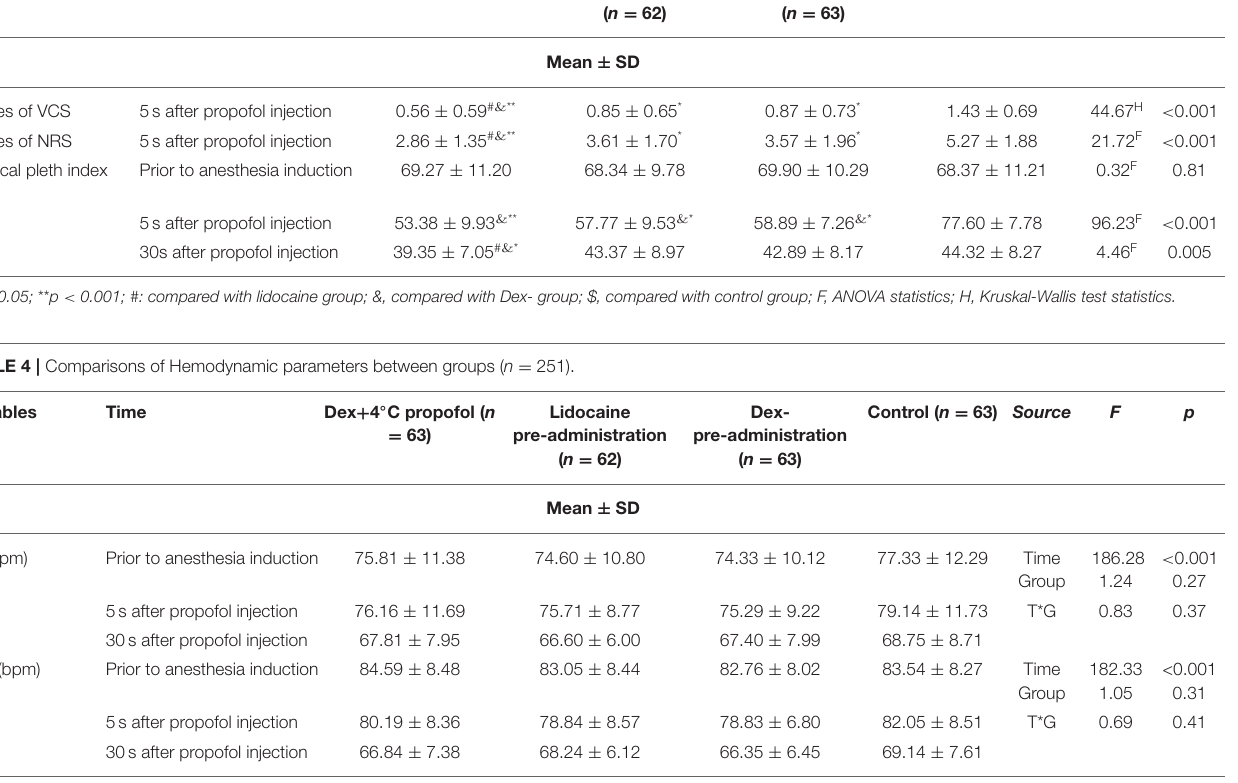
TABLE 3 | Comparisons of pain scores (VCS/NRS) and surgical pleth index between groups ( n = 251). Variable